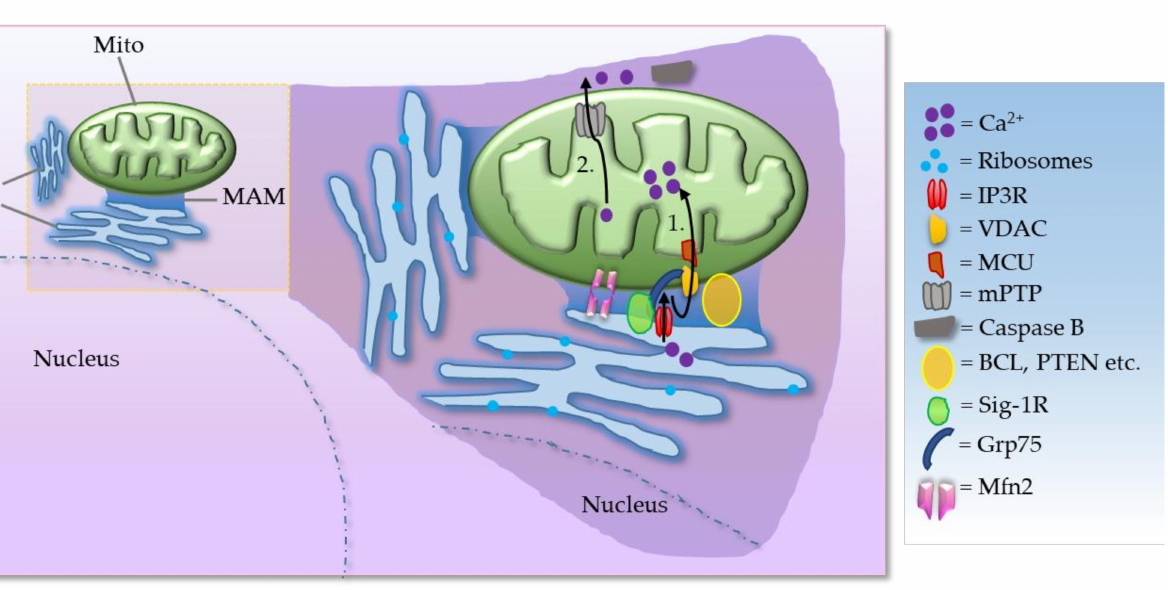
Figure 1. Simplified schematic diagram of basic components of the MAMs. Process 1, 2: Ca 2+ transfer and apoptosis— shown in black arrows. ER acts as the main source and mitochondria as the sink for Ca 2+ , while MAM has an essential role in Ca 2+ trafficking. Ca 2+ is mobilized through IP3R. IP3Rs located at the ER are one of the main Ca 2+ -release channels and upon activation by IP3 can transfer Ca 2+ to the mitochondria through an IP3R–VDAC–mitochondrial calcium uniporter (MCU) complex. In mammalian cells, IP3R forms a complex with Grp75 and VDAC to maintain ER– mitochondria contact sites. Additionally, mitofusin 2 (Mfn2) also serves as an important tether as described in the text. (Mito = mitochondria; mPTP = mitochondrial permeability transition pore; BCL = B-cell lymphoma 2 family of regulator proteins; PTEN = Phosphatase and tensin